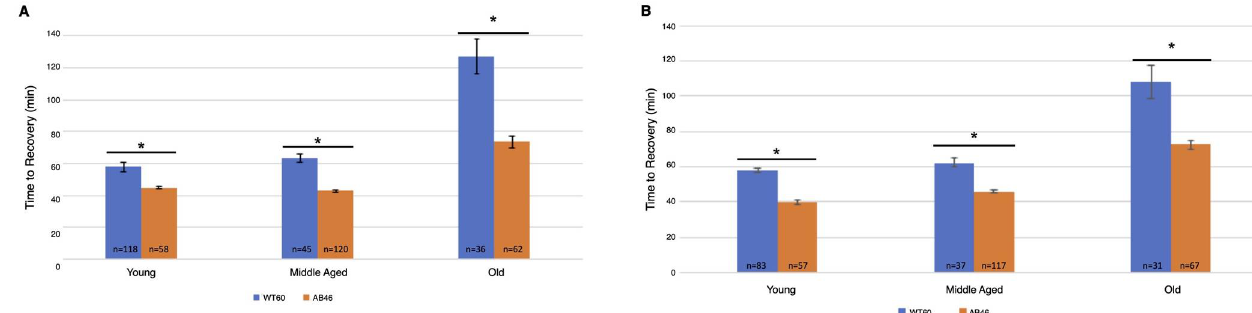
Figure 3. Recovery after one hour hypoxia under moderate or slow induction of spreading depression. Wild-type (WT60) and MSR-deficient (AB46) animals were exposed to one hour of hypoxia using a moderate nitrogen flow rate of 1.4 L/s ( A ) or a slow flow rate of 25 mL/s ( B ). After one hour of hypoxia, the animals were returned to standard atmosphere and allowed to recover, their activity was scored as the first movement detected by the Drosophila Activity Monitor. The number of individual animals ( n ) used for each age-group and genotype is shown on the graph. Error bars are the SEM. Significance is indicated by an asterisk where p < 0.0001 using an unpaired t -test.